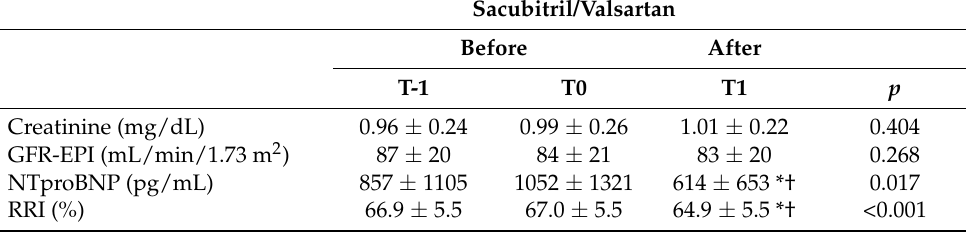
Table 2. Cont. Sacubitril/Valsartan Before After T-1 T0 T1 p Creatinine (mg/dL) 0.96 ± 0.24 0.99 ± 0.26 1.01 ± 0.22 Data expressed as mean ± standard deviation. p refers to linear fixed model. T-1 available in 49 patients. * p < 0.05 vs. T0; † p < 0.05 vs. T-1. CVP: central venous pressure; E/e’: the ratio between the peak of the E wave (E), through mitral pulsed Doppler at the level of the mitral leaflets, and early diastolic velocity peak (e’) at the level of the septal and lateral mitral annulus, through tissue Doppler imaging; GFR-EPI: estimated glomerular filtration rate by EPI formula; LAV: left atrial volume; LVEDV: left ventricular end-diastolic volume; LVEF: left ventricular ejection fraction; LVESV: left ventricular end-systolic volume; MR: mitral regurgitation; NT-proBNP: amino-terminal brain natriuretic peptide; PAPs: estimated systolic pulmonary arterial pressure; RRI: renal resistance index; SAP: systolic arterial pressure; TAPSE: peak of tricuspid annulus systolic excursion; TR: tricuspid regurgitation.